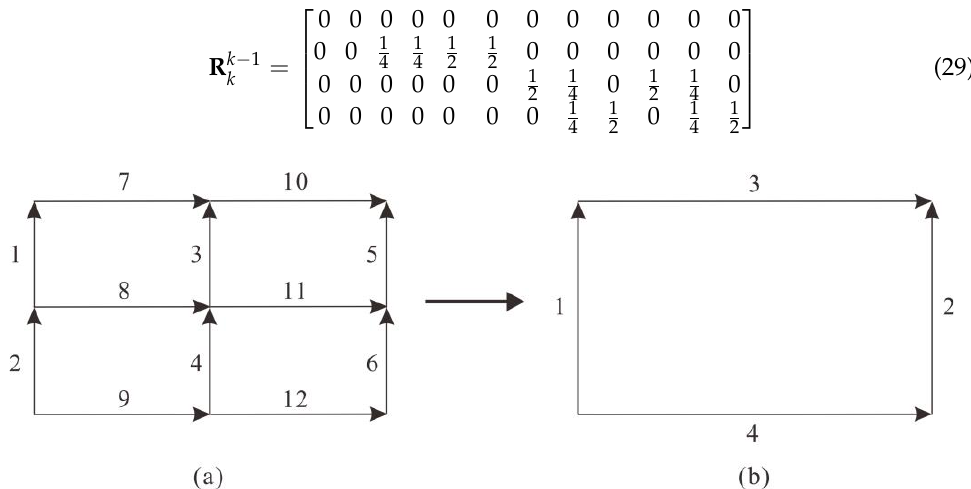
Figure 3. Diagram of restriction operator (Refer to [54]). ( a ) Fine grid; ( b ) coarse grid. We take edge 2 at the coarse grid as an example. Edge 2 on the coarse grid is contributed by edges 3, 4, 5, and 6 on the fine grid, with weights of 1/4, 1/4, 1/2,1/2. The restriction matrix constructed by all edge weights is shown in Equation